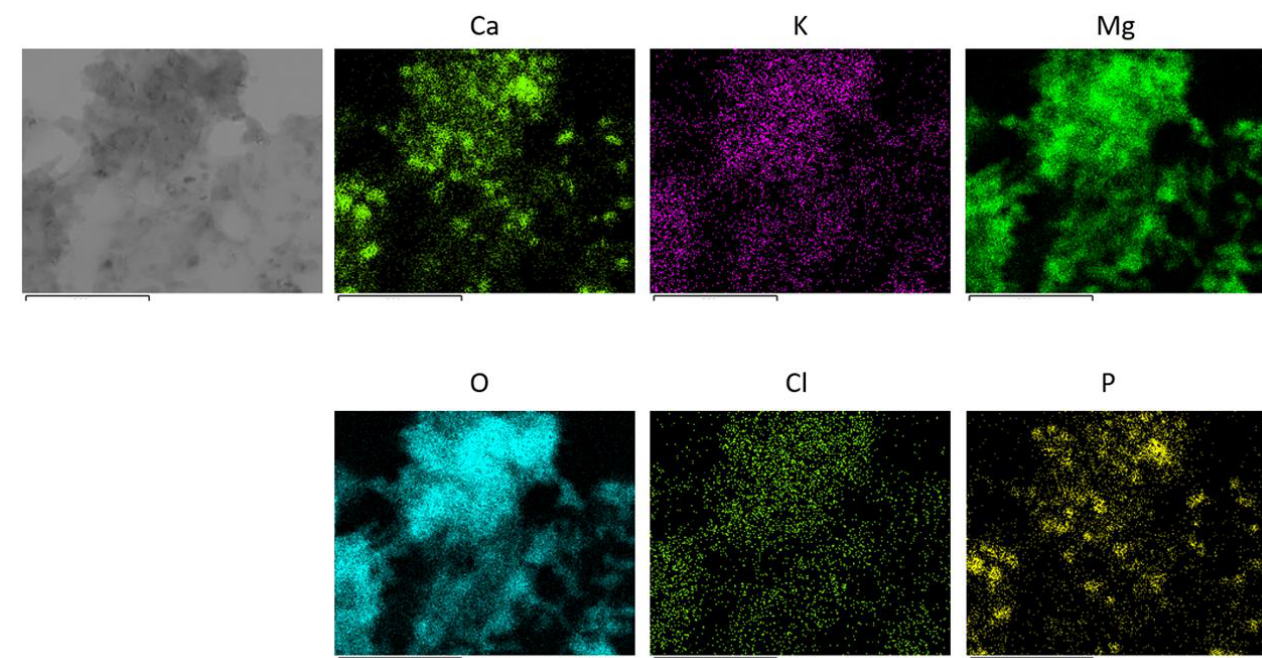
Figure 3. HR-TEM mapping of Eco-base-Fj (scale bar: 250 nm) .